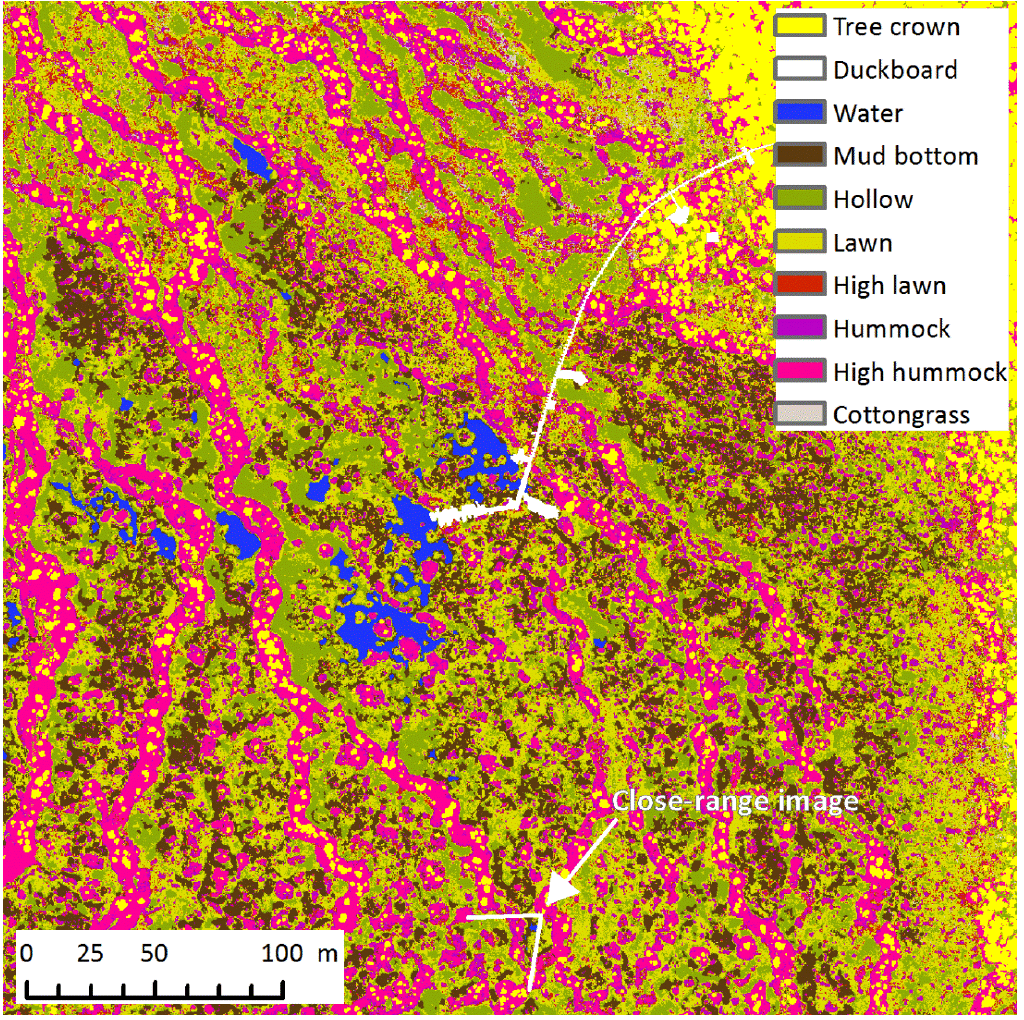
Figure 14. RF-classified map of the AOI. The field-of-view of the close-range image shown in Figures 7 and 16 is marked in the